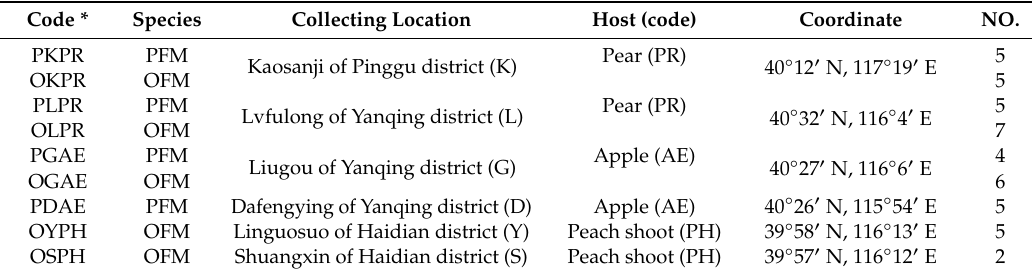
Table 1. Samples of the peach fruit moth (PFM), Carposina sasakii , and the oriental fruit moth (OFM), Grapholita molesta , used in the